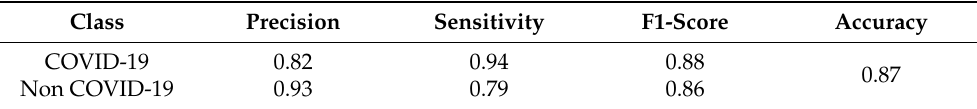
Table 5. Baseline Results.